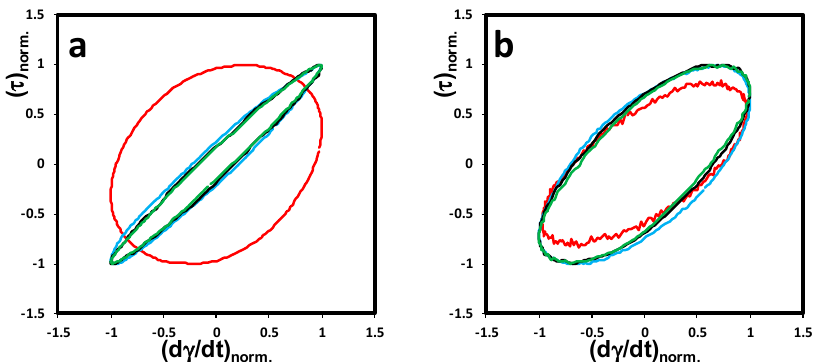
Figure 5. Normalized elastic Lissajous-Bowditch loops of N-CNT / PVDF nanocomposites containing 2.0 wt% of carbon nanotubes synthesized on ( a ) Ni and ( b ) Fe catalysts using cone-plate geometry (truncation of 47 µ m) at 240 ◦ C. Projections on the elastic ( τ - γ ) planes are presented at strain amplitudes of γ 0 = 1.0, 5.0, 50, and 70% and an angular frequency of ω = 0.1 rad / s.